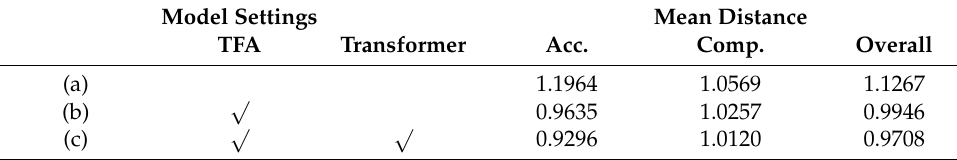
Table 2. Quantitative performance with different components.